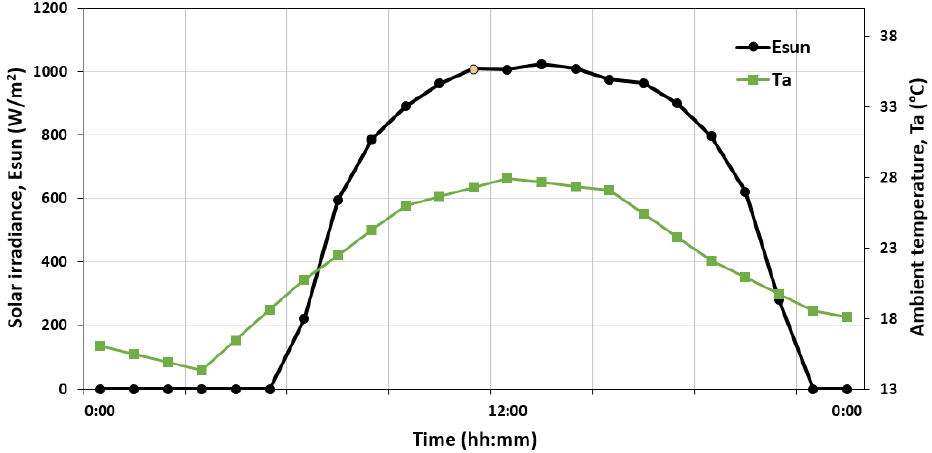
Figure 7. Variation of solar irradiance and ambient temperature (28 July 2016).